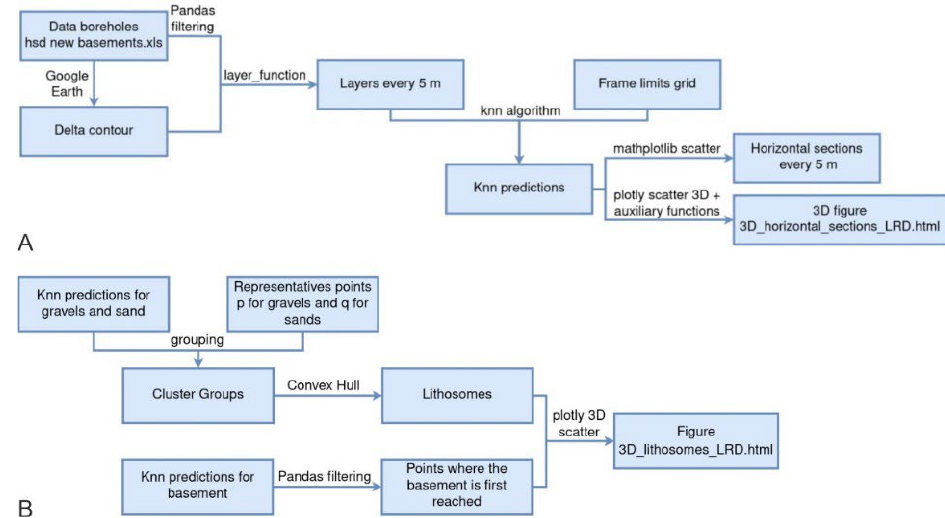
Figure 3. Flow diagram showing the methodological stages, including data compilation and software implementation for the 3D mapping of ( A ) the consecutive 5 m-equispaced set of horizontal sections of the granulometry classes created with the KNN algorithm from 0 to 120 m below sea level in the onshore LRD and ( B ) the stratigraphic architecture of the onshore LRD (coarse lithosomes and the basement top surface) created with Python libraries.